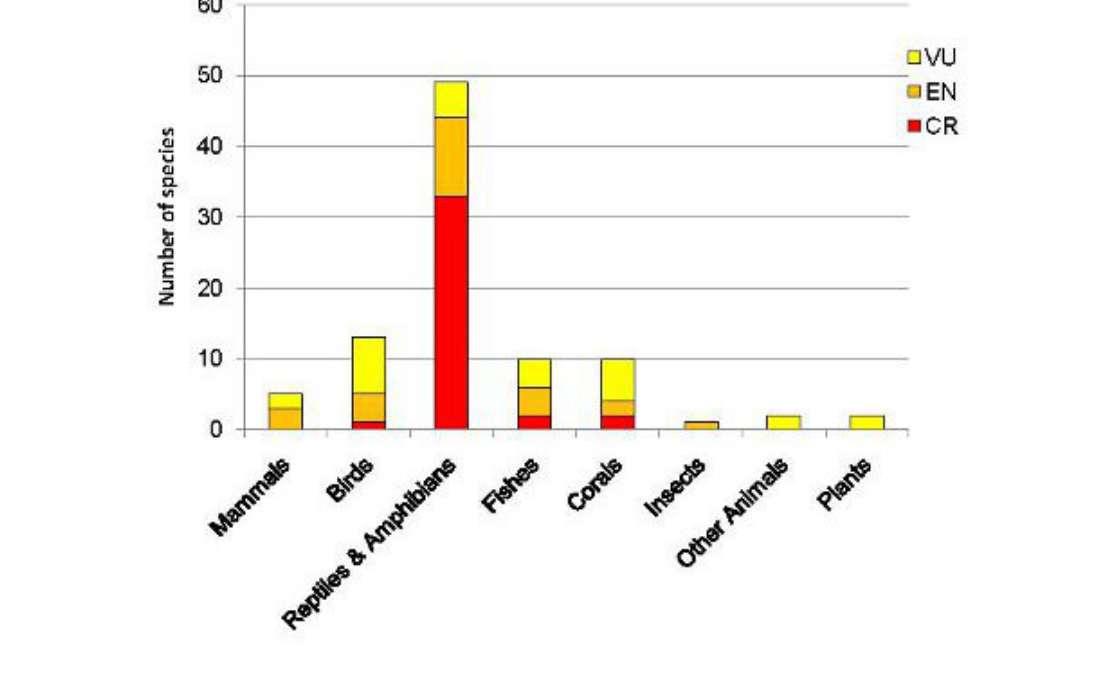
Fig. 1. International Union for Conservation of Nature Red List status for Haitian species that have been identified as threatened (CR - Critically Endangered; EN - Endangered; VU - Vulnerable; IUCN